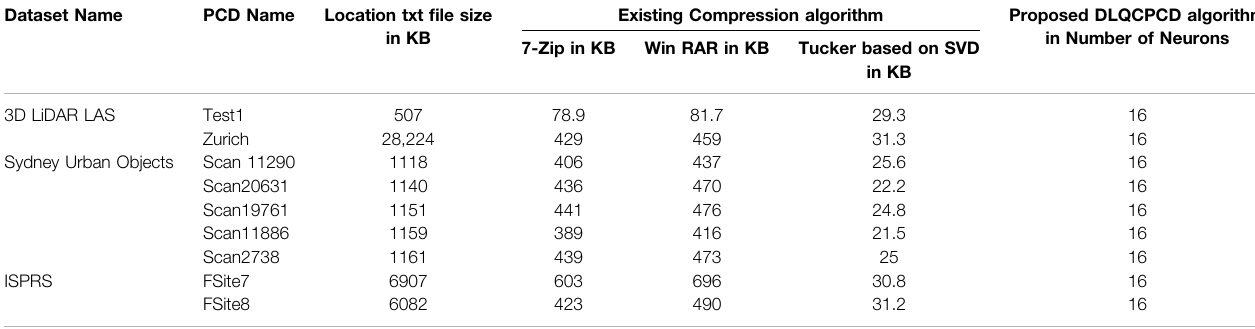
TABLE 4 | Comparison of compression performance between the proposed method and the existing algorithms. Dataset Name